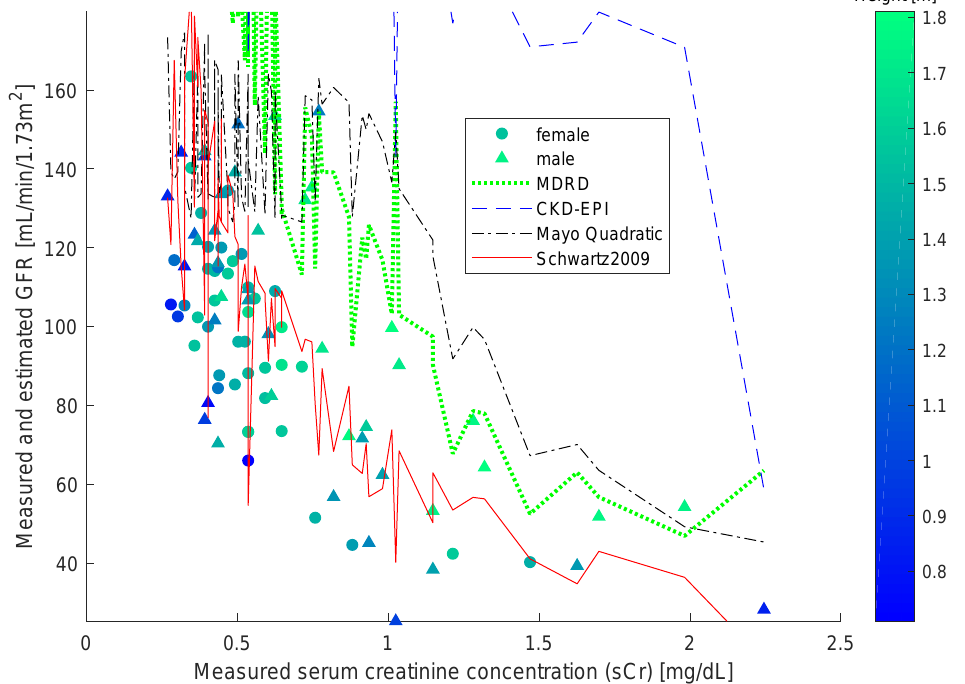
Figure 2. Comparison of predictions made using different equations (MDRD, CKD-EPI, Mayo Quadratic and updated Schwartz) on a pedriatic patients’ dataset. The serum creatinine concentration refers to the IMDS-traceable